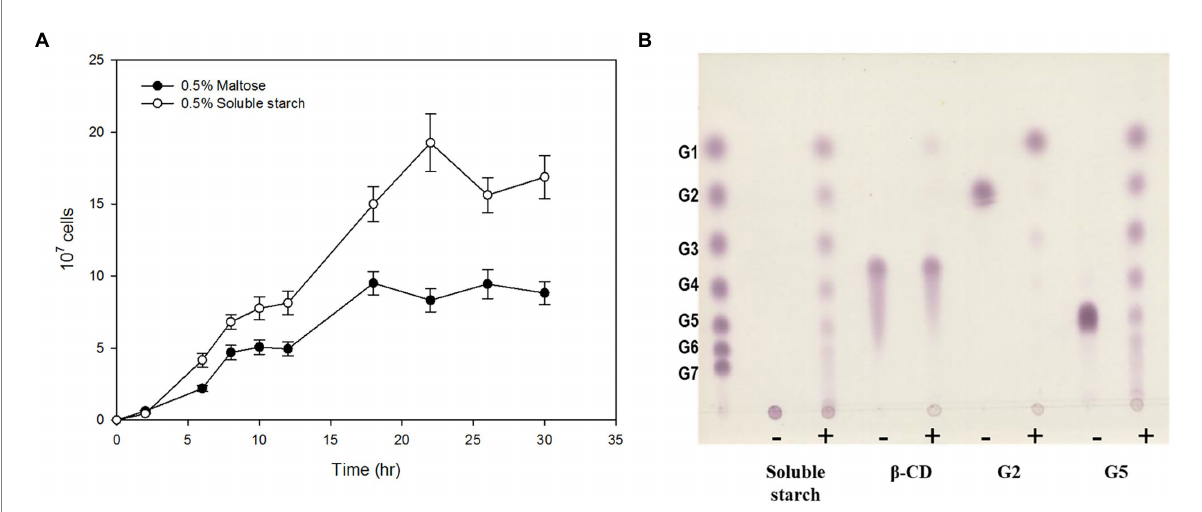
FIGURE 1 α -Glucan utilization by Pyrococcus sp. ST04. (A) Growth curves of Pyrococcus sp. ST04 on maltose (closed circles) and soluble starch (open circles). (B) Hydrolytic activity of ST04 crude extract on various substrates. Reactions were performed at 80 ° C for 12 h. ( − ) and (+) indicate presence and absence of crude extracts of Pyrococcus sp. ST04, respectively.